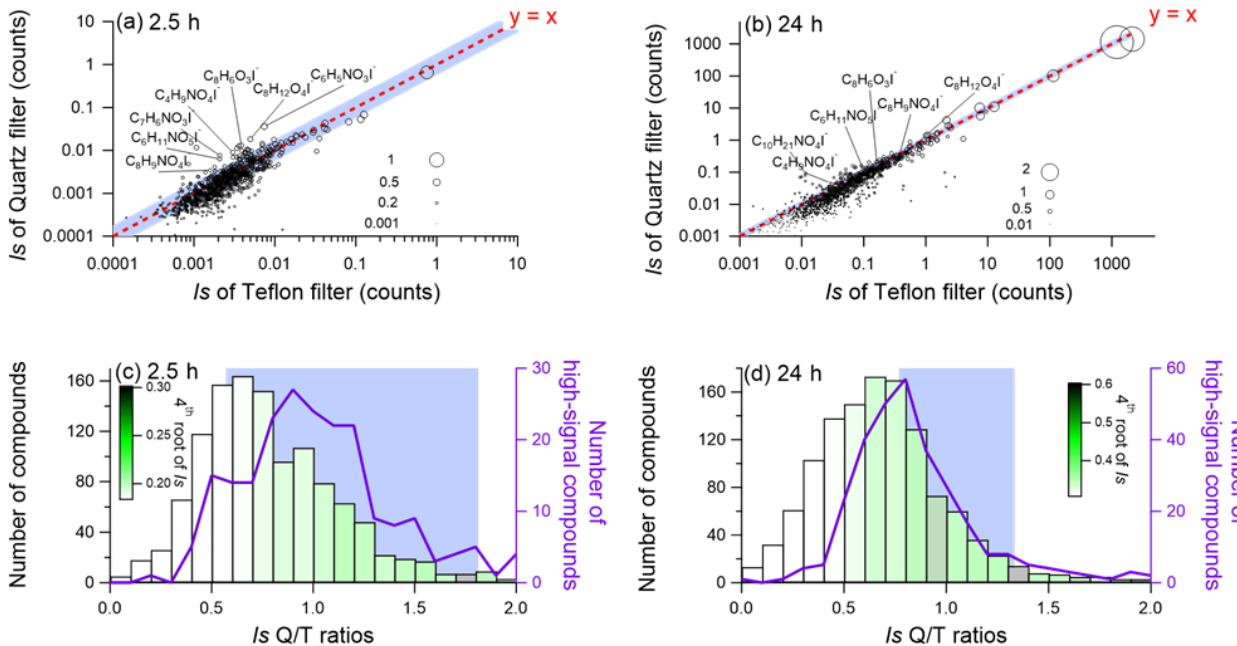
Figure 8. Comparison of the integrated signal intensities of all identified compounds for the quartz fiber and Teflon filter samples for (a) 2.5h samples and (b) 24h samples. The size of symbols in panels (a) and (b) is proportional to the fourth root of the signal intensity of each compound from the quartz filter. The frequency distribution (number of compounds) per signal ratio of quartz / Teflon for all compounds (green bars) and high-signal compounds (highest 25% signal compounds) only (purple lines) for 2.5h samples (c) and 24h samples (d) are shown. The bars in panels (c) and (d) are colored by the average of the fourth root of the signal intensity of the quartz filter. The blue shaded area in each panel represents the possible distribution of Is ratios of quartz / Teflon from the relative errors from the duplicate tests of 2.5h (25% for quartz and 31% for Teflon) and 24h (9% for quartz and 18% for Teflon) samples. The upper and lower limits for the 2.5h quartz / Teflon Is ratios were calculated as (1 + 25%) / (1 − 31%) and (1 − 25%) / (1 + 31%), respectively. The upper and lower limits for the 24h quartz / Teflon Is ratios were calculated as (1 + 9%) / (1 − 18%) and (1 − 9%) / (1 + 18%), respectively.